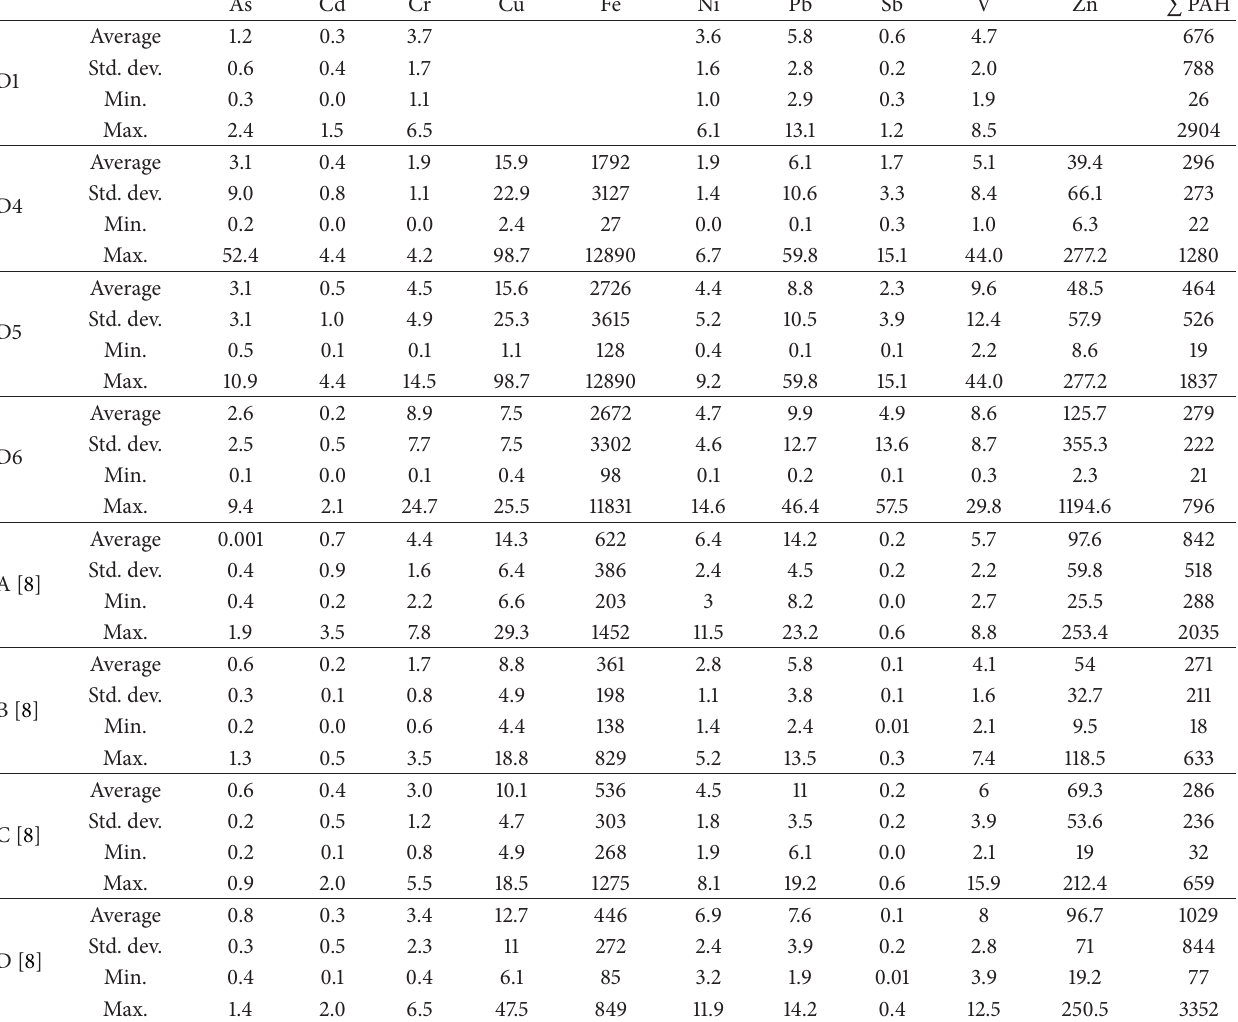
Table 1: Daily fluxes of inorganic elements ( 𝜇 g ⋅ m −2 ⋅ day −1 ) and total PAH (ng ⋅ m −2 ⋅ day −1 ) measured in this study and in Rossini et al.’s study [8]. As Cd Cr Cu Average 1.2 D1 Min. Max.